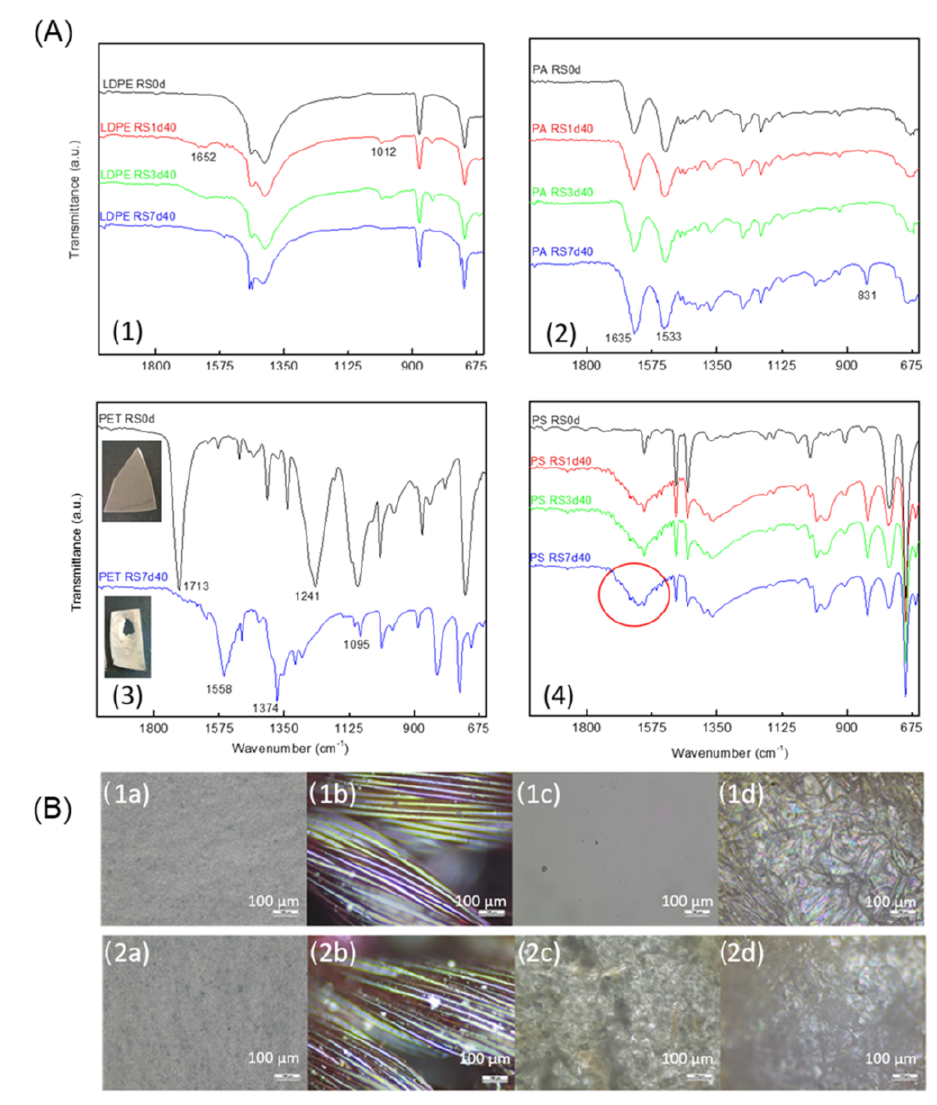
Figure 5. ( A ) FTIR spectra of RS samples of LDPE (1), PA (2), PET (3) and PS (4) at different test times in KOH 20% at 40 ◦ C and ( B ) Optical microscopy images of RS samples (LDPE (a), PA (b), PET (c) and PS (d)), before the test (1) and after one week in KOH 20% (2). Samples are identified as RSXdY, where X and Y indicate the number of days and the treatment temperature, respectively, and the red circle indicates a spectral region of interest mentioned in the